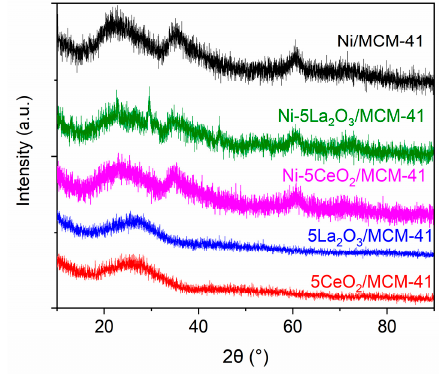
Figure 4. X ‐ ray diffraction (XRD) patterns of the synthesized catalysts. Figure 4. X-ray diffraction (XRD) patterns of the synthesized